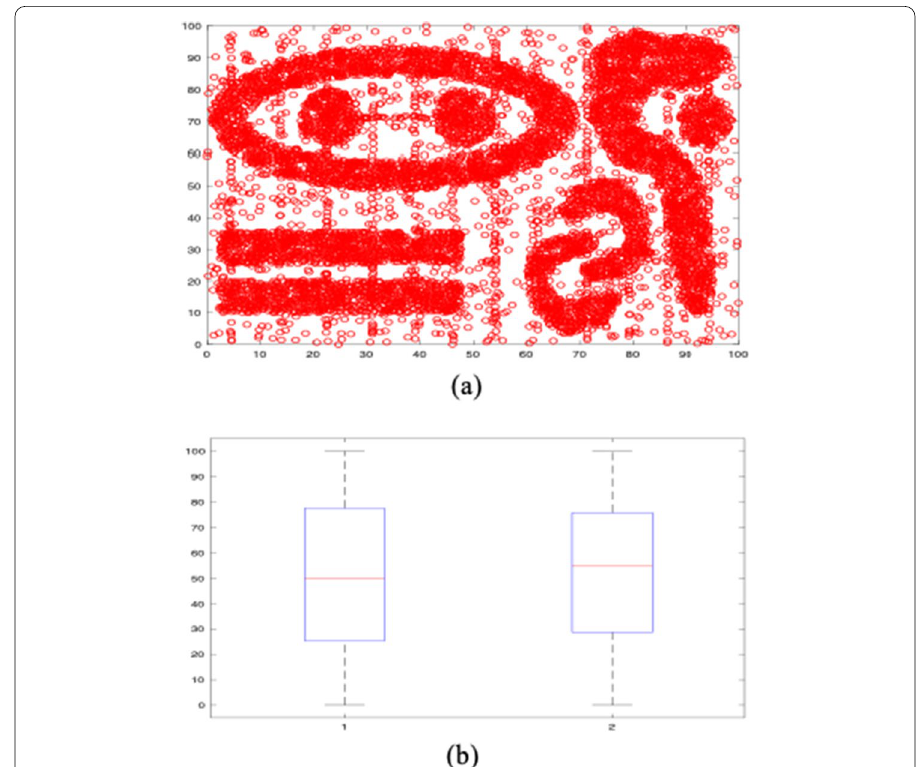
Fig. 6 a An example of dataset having different shapes of inlier clusters contaminated with noise. b Traditional boxplot showing no outliers/